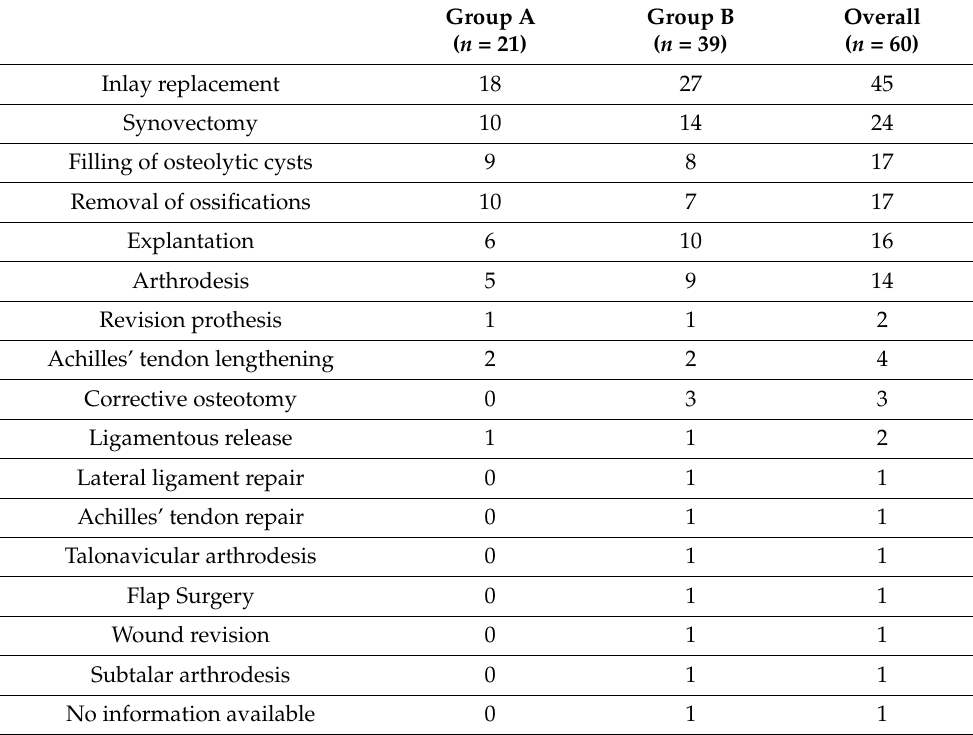
Table 3. Detailed numbers regarding the types of procedures performed to address the complications related to TAA mentioned above. In a total of 44 cases, one or more procedures were performed within the secondary